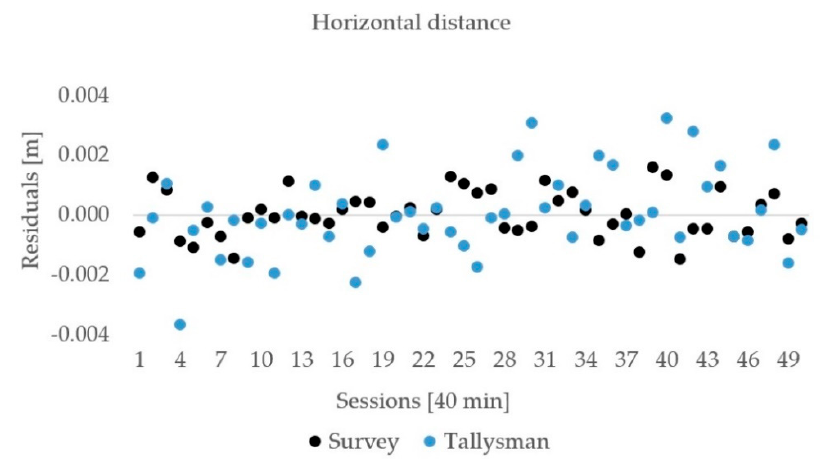
Figure 7. Horizontal distance residuals for the low-cost uncalibrated antennas.